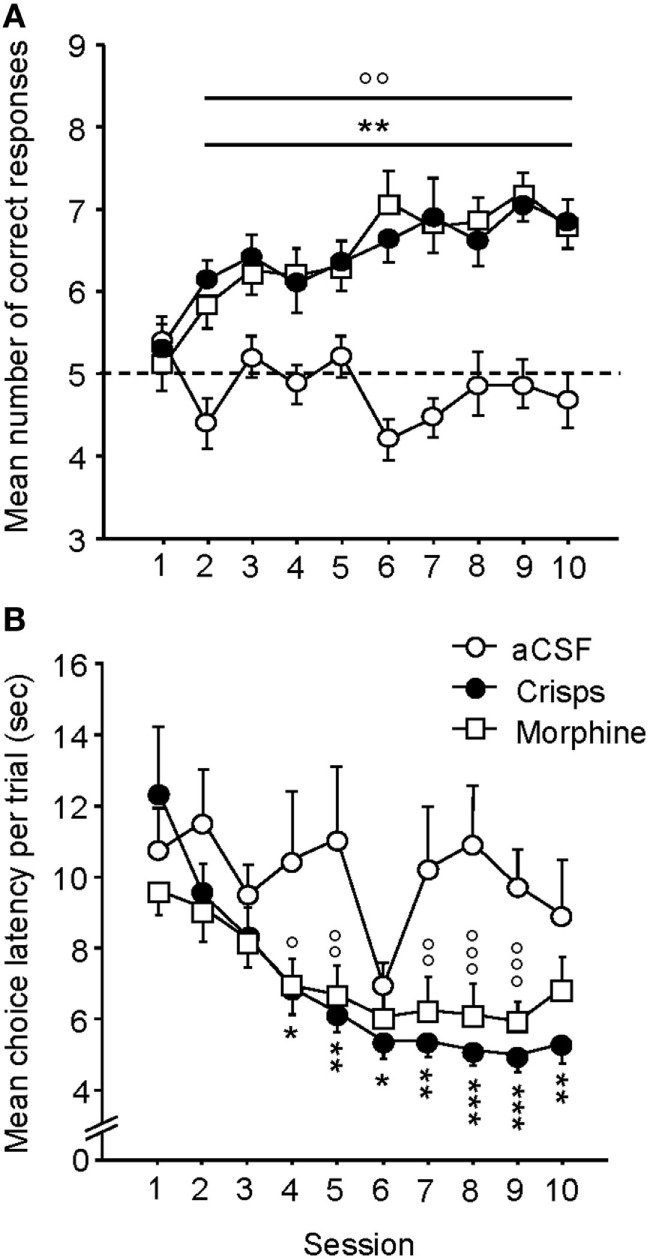
Acquisition of the cue-guided Y-maze discrimination task in food (crisps) and drug (morphine) self-rewarded mice. (A) Mean (±SEM) number of correct responses over 10 training sessions (10 trials/day). Both natural (“Crisps” group: black dot) and pharmacological (“Morphine” group: white square) rewards allowed the acquisition of this task as compared to artificial cerebrospinal fluid (aCSF) (white dot) injected group (vs Crisps group from day 2 to 10: **p < 0.01; vs Morphine group from day 2 to 10: °°p < 0.01). (B) Analysis of mean (±SEM) latencies to complete a trial (in seconds) over the 10 training sessions. Both rewarded groups decrease their choice latency over trials and completed trials faster than aCSF group (vs Crisps group: *p < 0.05; **p < 0.01; ***p < 0.001; vs Morphine group: °p < 0.05; °°p < 0.01; °°°p < 0.001).